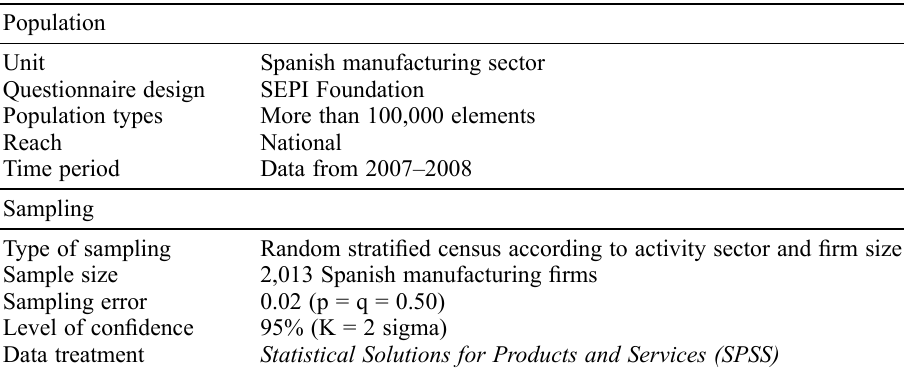
Table 1. Technical data from the